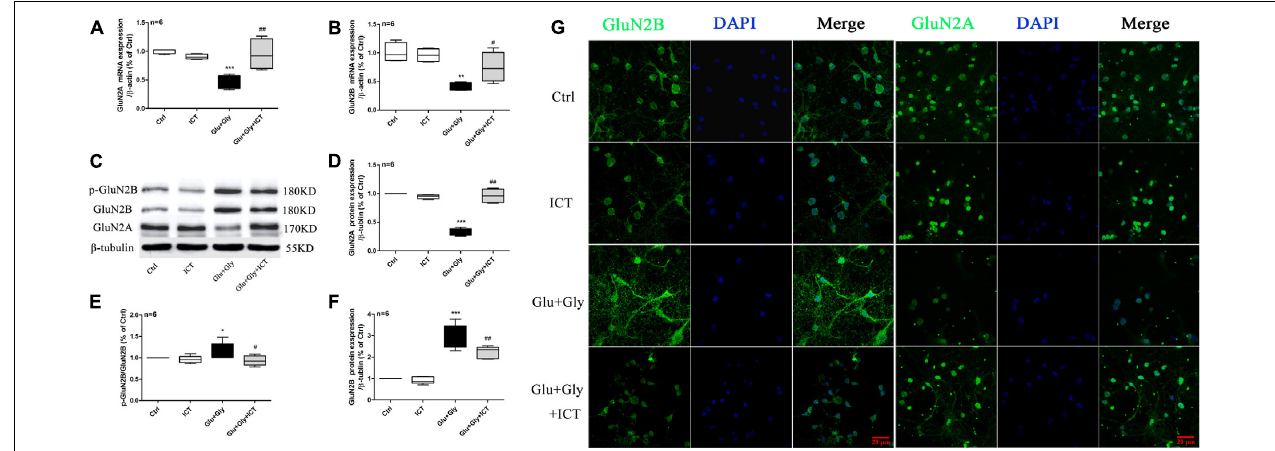
FIGURE 2 | The expression levels of GluN2A and GluN2B and the phosphorylation level of GluN2B are regulated by ICT treatment after glutamate-induced injury. GluN2B and GluN2A mRNA and protein levels (A–F) in the different groups (control, 1 µ M ICT, Glu+Gly and Glu+Gly+1 µ M ICT) were analyzed by RT-qPCR and Western blot, respectively, and are expressed as the mean ± SEM ( n = 6). GluN2B and GluN2A protein localization is shown in the immunofluorescent images (G) . One-way ANOVA followed by Newman-Keuls test, (A) : F = 10.80, (B) : F = 10.28, (D) : F = 79.78, (E) : F = 3.720, (F) : F = 55.75; * p < 0.05, ** p < 0.01, and